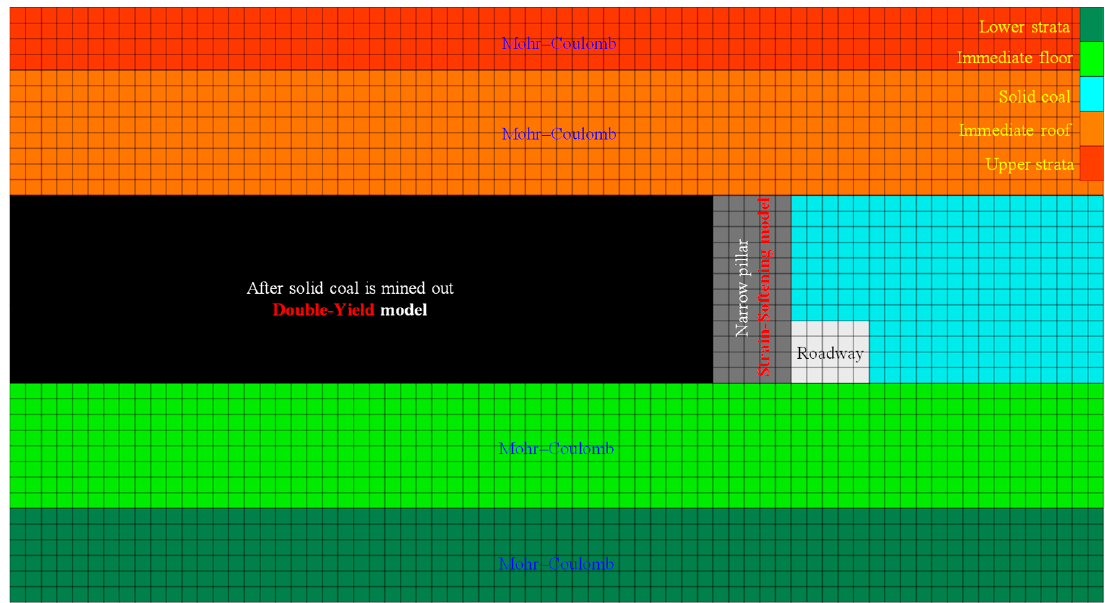
Figure 20. Constitutive model of FLAC 3D used gob-side entry driving in fully mechanized caving.